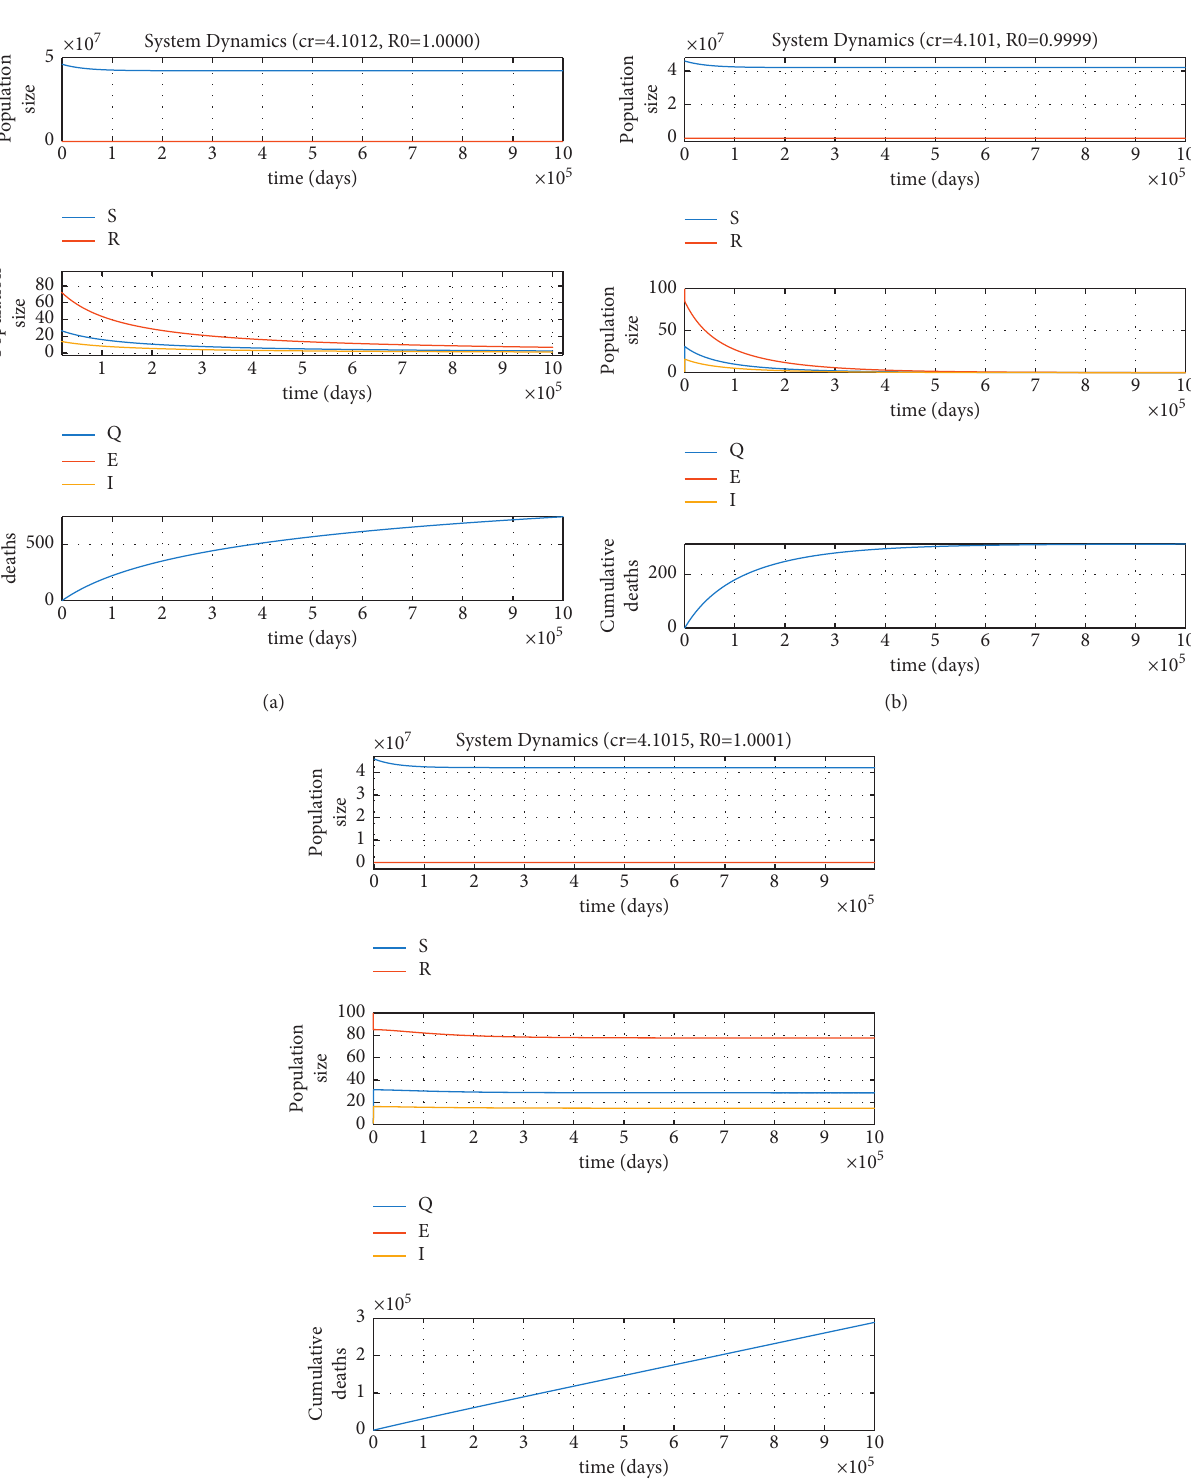
Figure 3: Comparison of the infection evolution for the basic reproduction number close to unity: (a) infection evolution for the unity basic reproduction number, (b) infection evolution for the basic reproduction number slightly below unity, and (c) infection evolution for the basic reproduction number slightly over